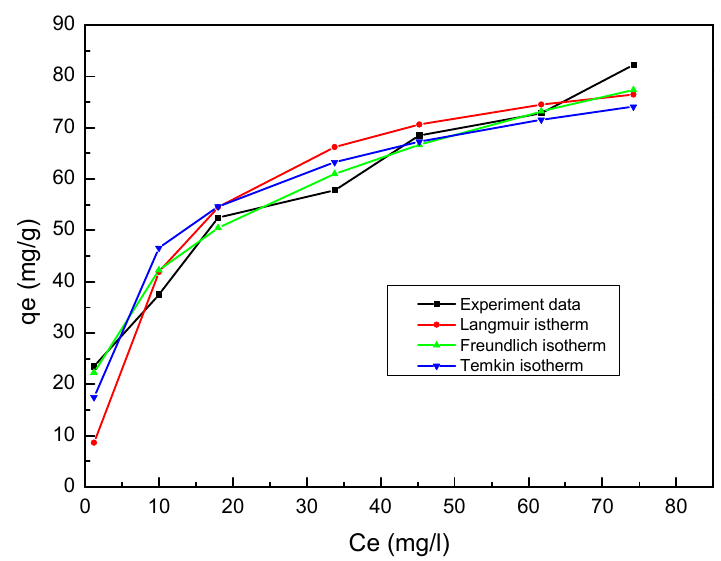
Figure 13. Adsorption isotherm of Rh B by nZVI/rGO. (initial pH = 5.0; nZVI/rGO dosage = 40 mg; temperature = 25 °C ; and Rh B concentration = 60 mg/L).